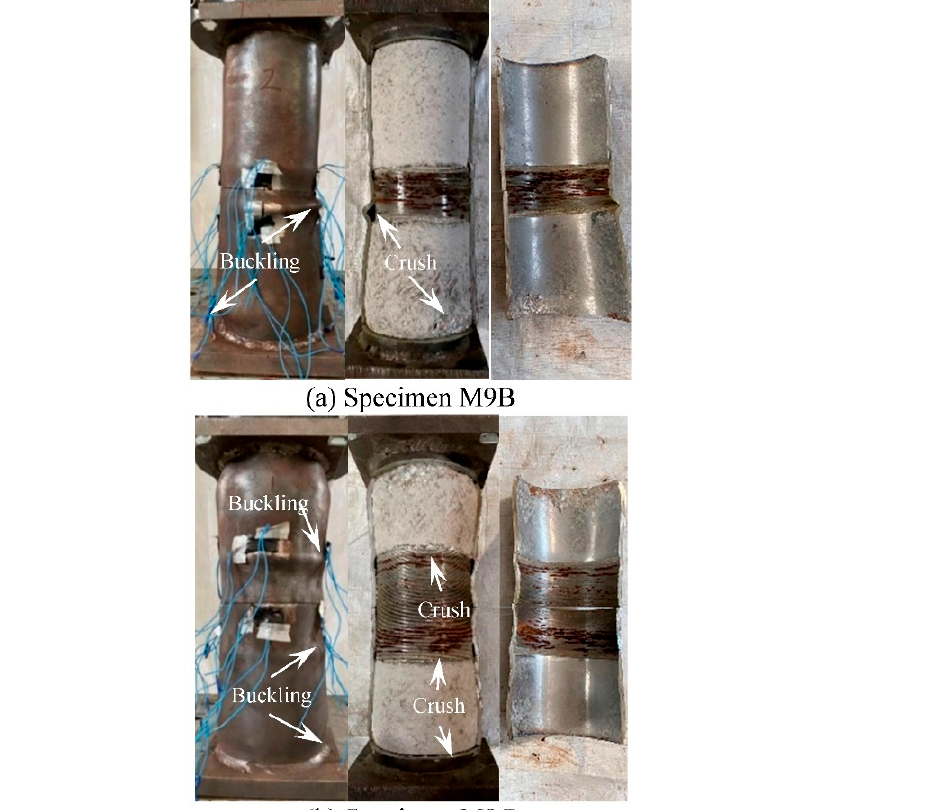
Figure 8. Failure modes of specimens with long thread.